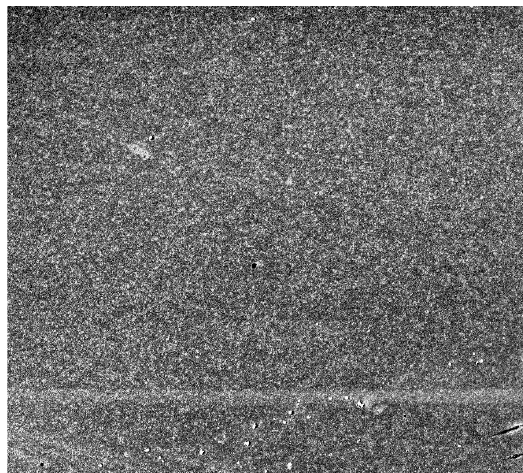
layer deposited onto BL(0V) at different magnificent - a) at 20 kX and b) 100 2